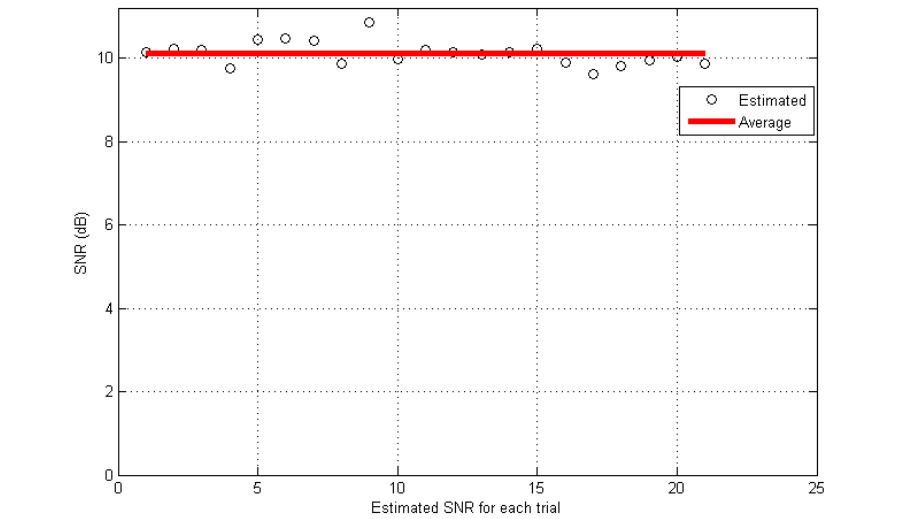
Figure 18. Estimated available